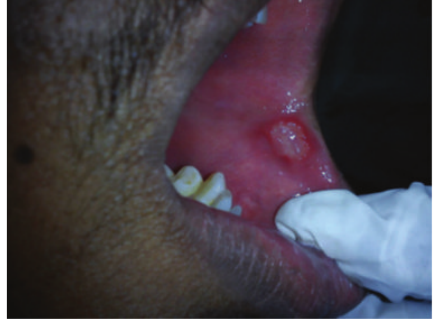
Figure 3: Ulcers on left commissure of buccal mucosa.